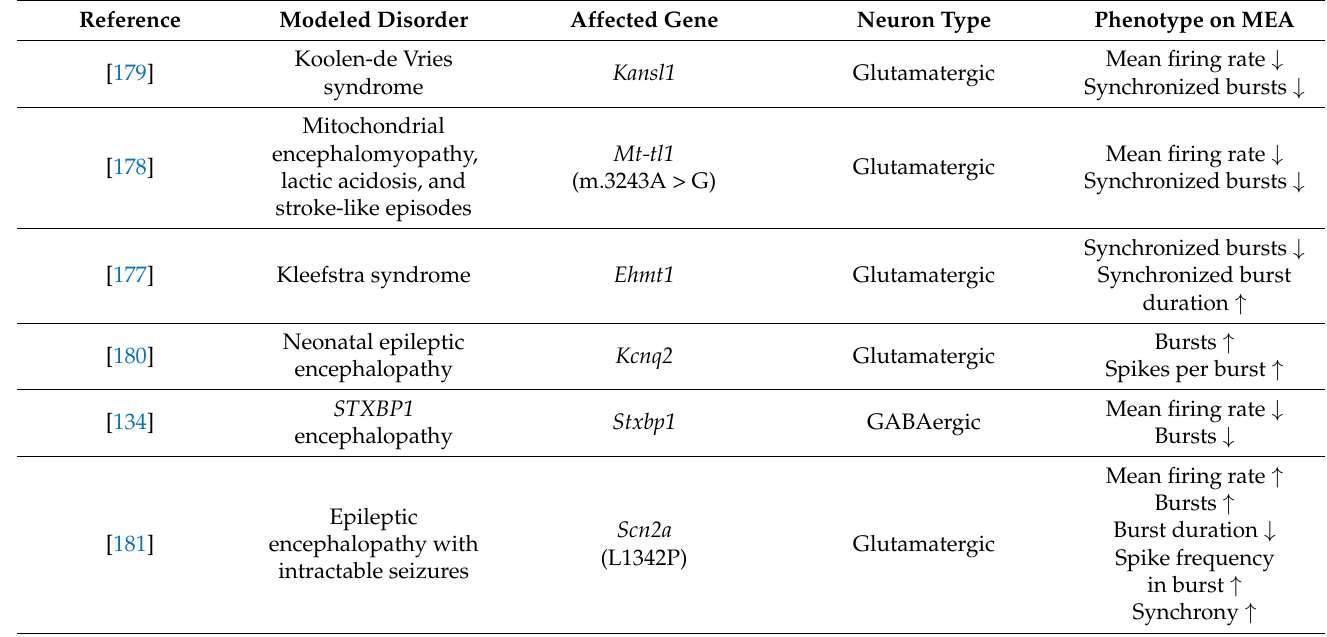
Table 1. hiPSC-derived genetic 2D neuronal models of neurodevelopmental disorders and neurode- generative diseases on